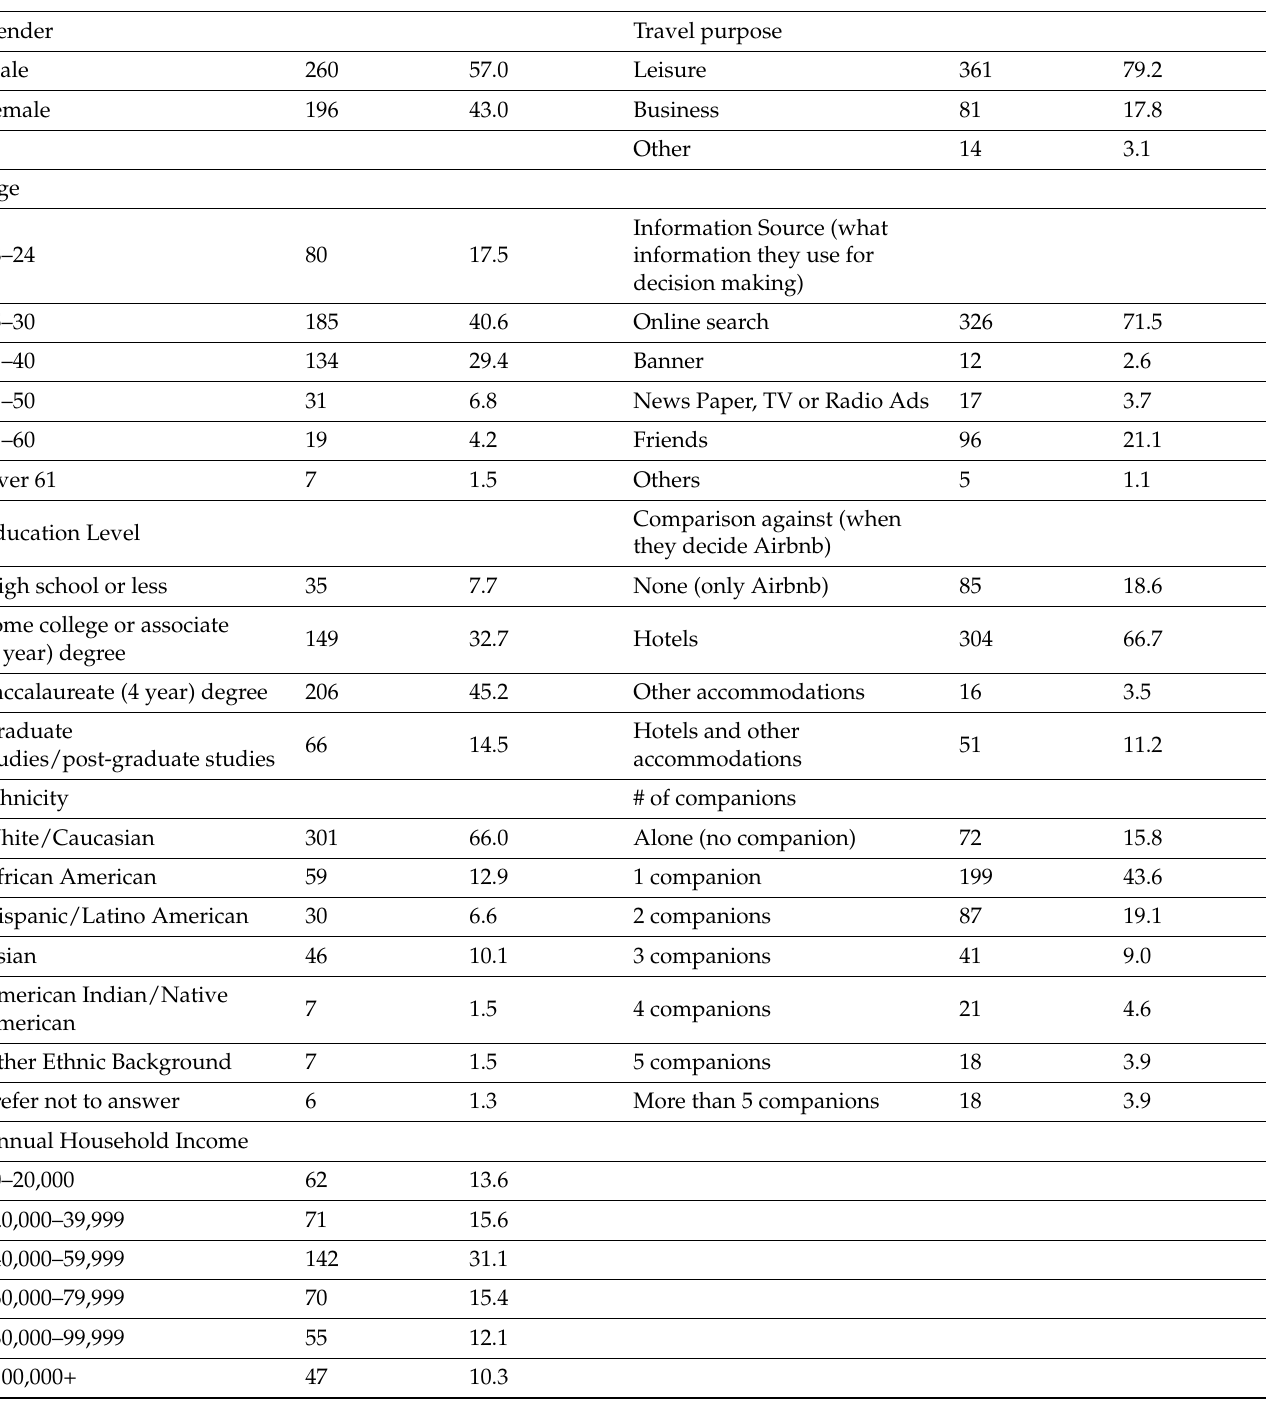
Table 1. Characteristics of respondents ( n =